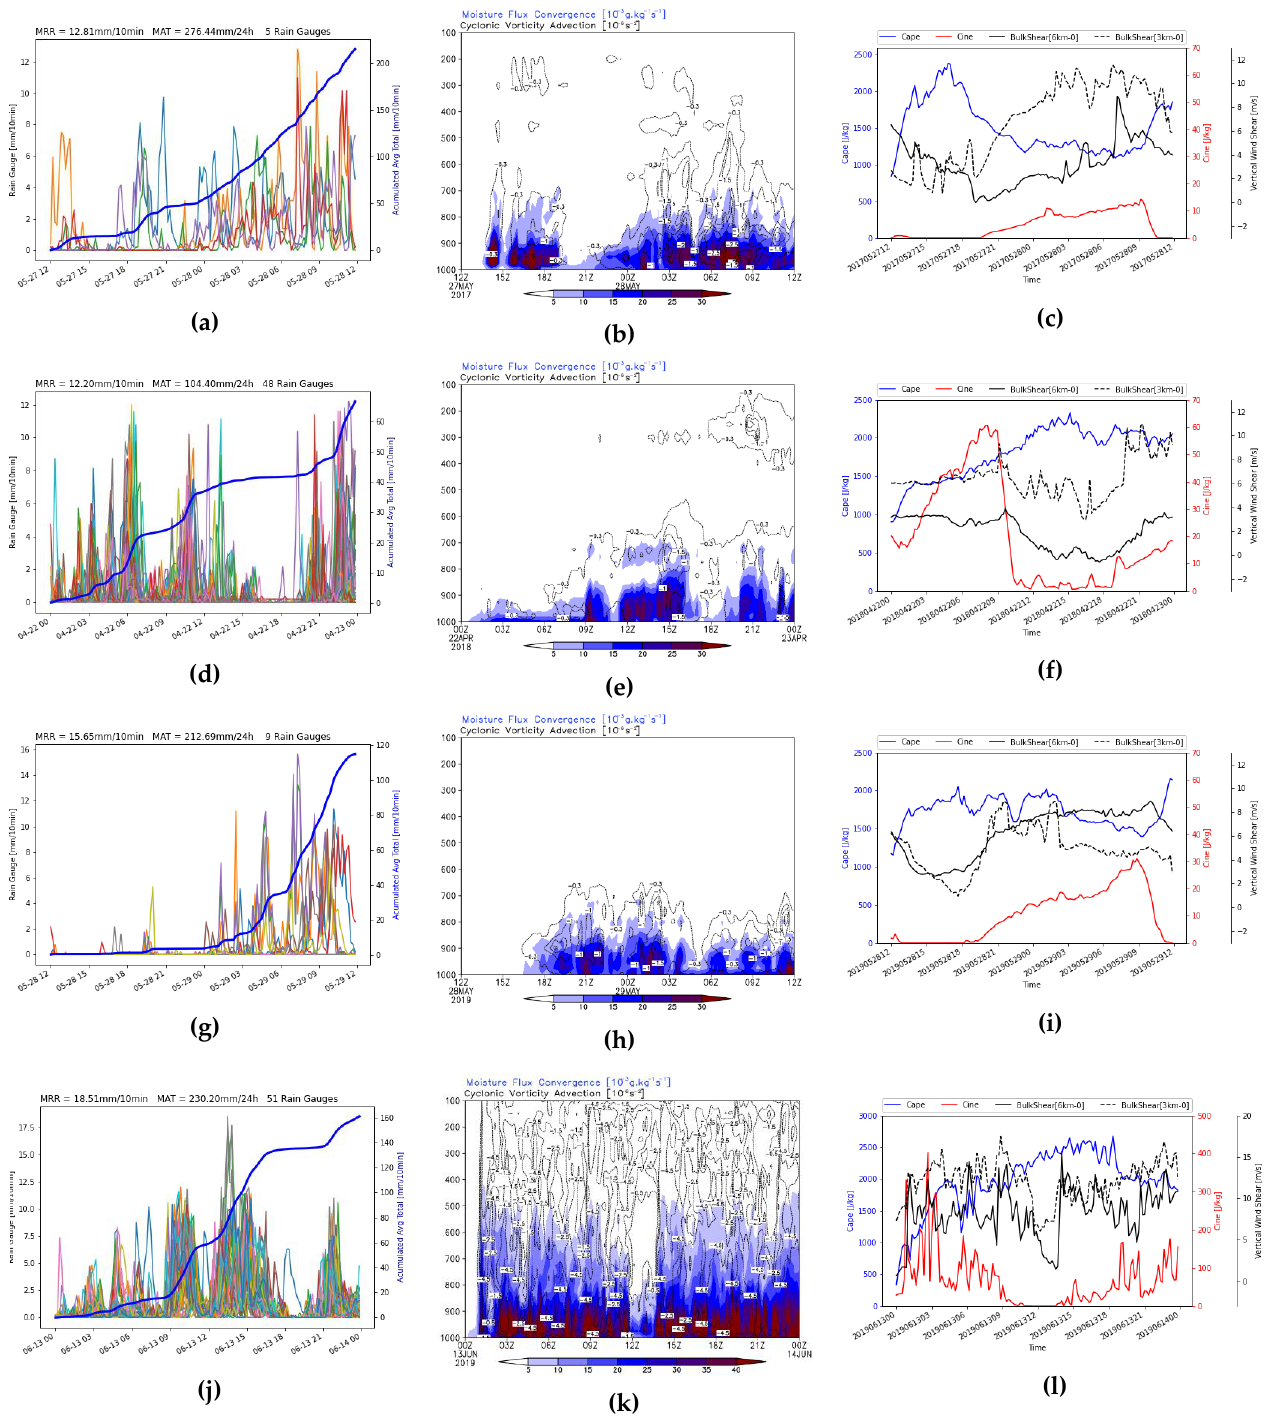
Figure 10. As in Figure 9, but for event 1 from ( a – c ), for event 3 from ( d – f ), for event 4 from ( g – i ), and for event 5 from ( j – l and for event 5 from ( j – l ).